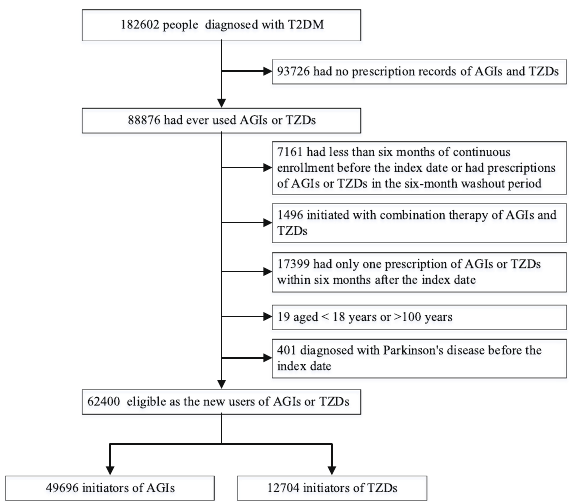
Fig. 1 Flowchart of participants in the study cohort. T2DM type 2 diabetes mellitus, AGIs alpha glucosidase inhibitors, TZDs